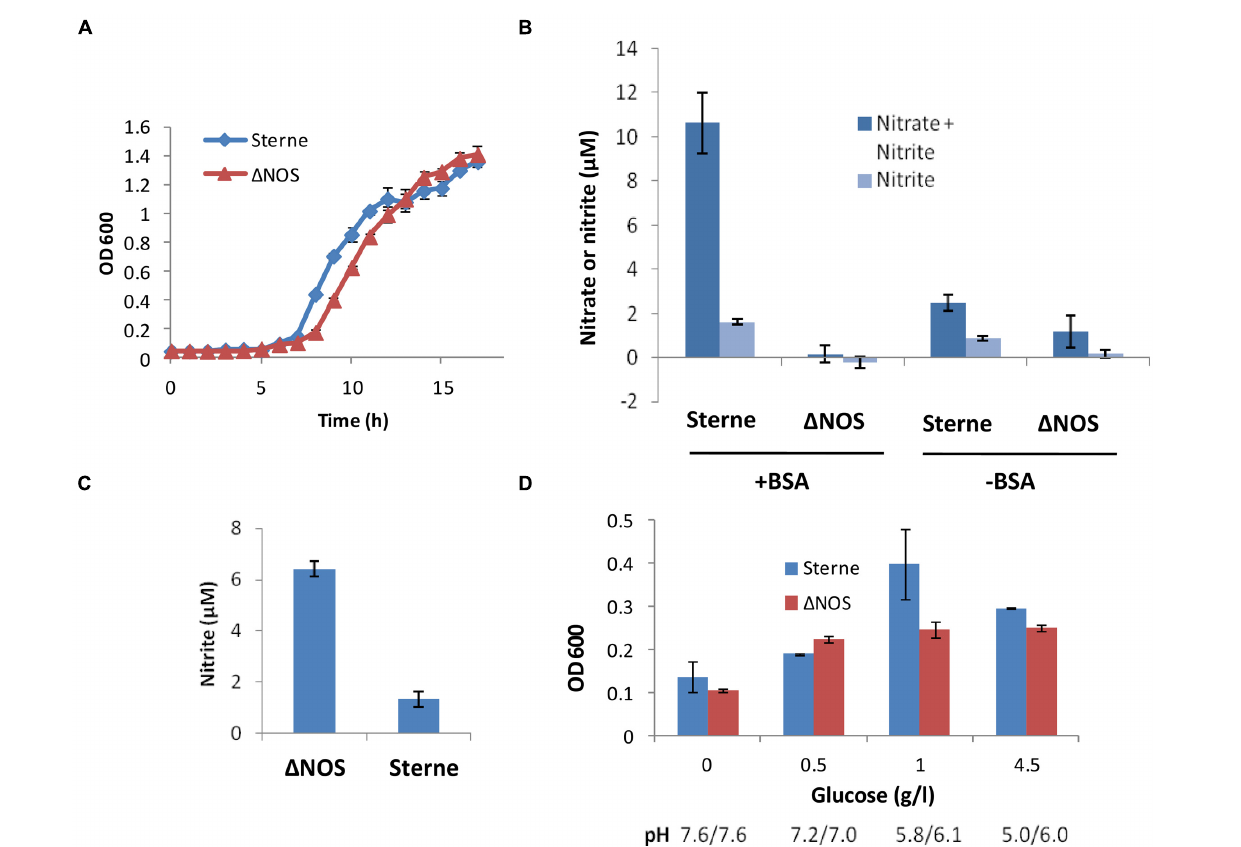
FIGURE 1 | Growth properties of Sterne and (cid:2) NOS strains (A,D) and accumulation of nitrate/nitrite in cultures (B,C). (A) The growth was measures as OD 600 at 37 ◦ C and shaking at 300 r.p.m. after inoculation of Luria broth (LB) medium with equal amounts of bacteria from overnight cultures. (B) Nitrate and nitrite were measured using a colorimetric Griess test (Life Technologies) in the sups of cultures grown in 12-well plates upon inoculation of 3 × 10 6 spores per ml of DMEM/F12 medium supplemented with 1 mg/ml Bovine serum albumin (BSA), with shaking in at 5% CO 2 , 37 ◦ C for 18 h. The background values corresponding to the control wells with medium were subtracted from those with sups. The OD 600 of the Sterne vs. (cid:2) NOS cultures measured in 200 μ l volumes using 96-well plate were 0.48 vs. 0.36 (without BSA) and 1.07 vs. 0.77 (with BSA), respectively. No substantial acidification of the medium was detected, demonstrating the absence of acidic fermentation. (C) The appearance of nitrite as a result respiration on nitrate in the Complete Serum-Free Medium (CSFM) culture medium containing 300 μ M of nitrate was measured using Griess test. Cultures were grown at 37 ◦ C and shaking at 300 r.p.m. for 17 h upon inoculation of 3 × 10 6 spores per ml of CSFM. (D) The growth of static cultures at different glucose concentrations in the DMEM medium at